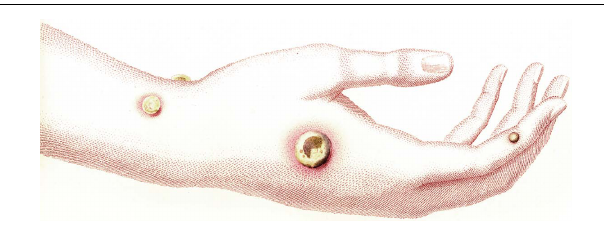
FIGURE 1 |The Cow Pox sores on the hands of Sarah Nelmes. (From Jenner, 1798).